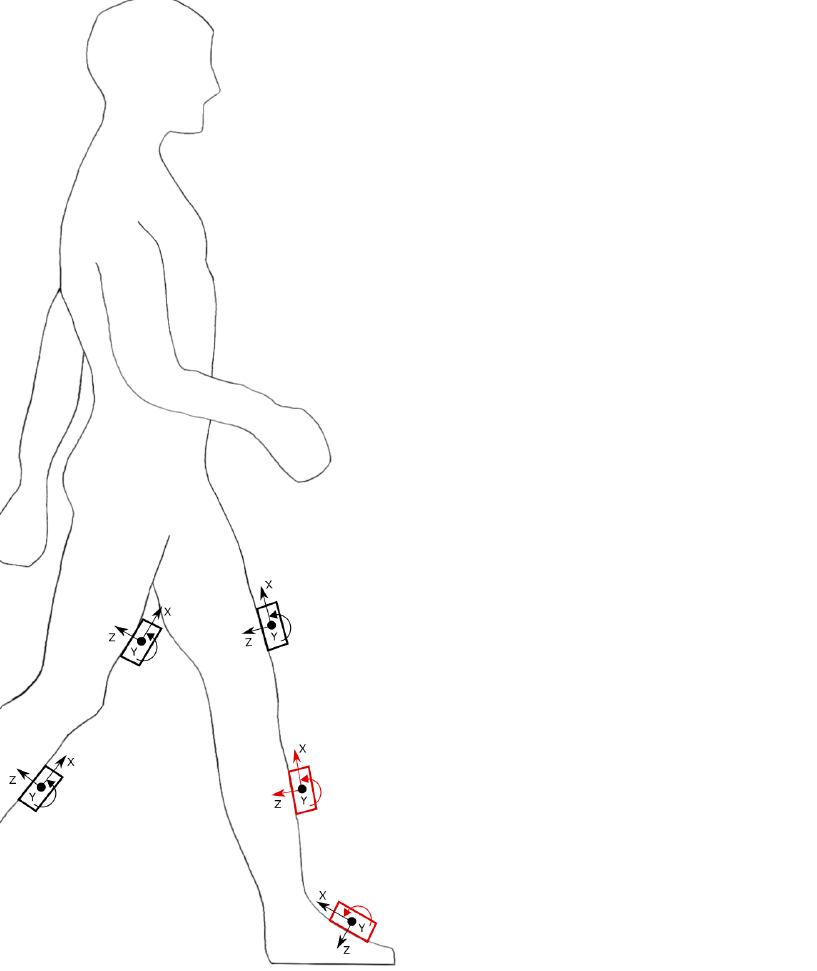
Figure 1. Location of inertial sensors position on the lower limbs (black) and the used sensors’ readings (red).